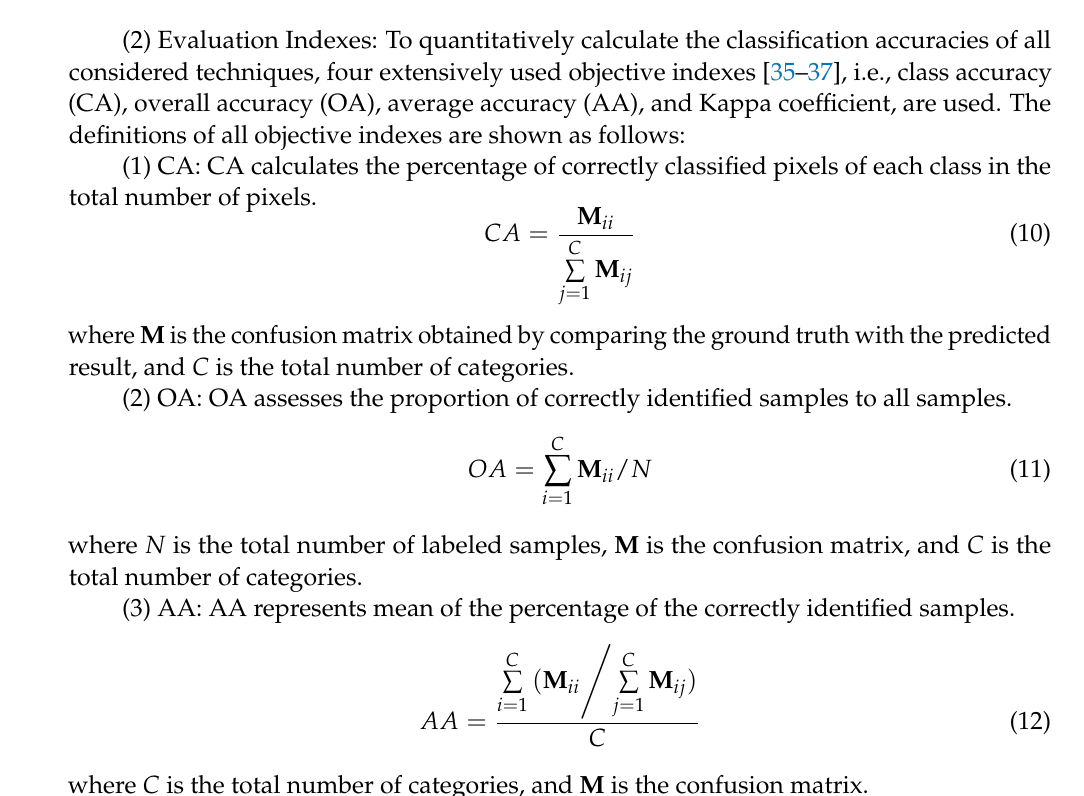
Figure 4. Honghu dataset. ( a ) False color composite. ( b ) Ground truth. ( c ) Label